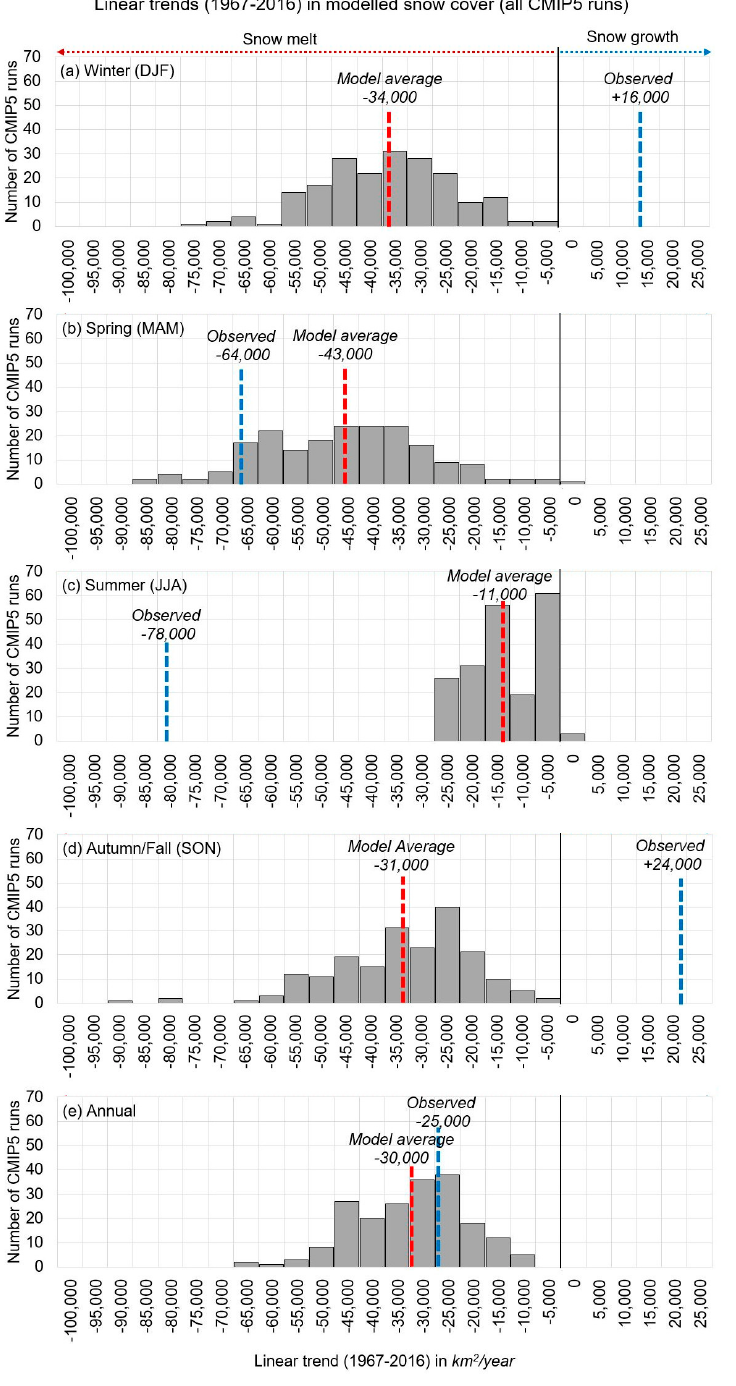
Figure 3. Distribution of linear 1967–2016 Northern Hemisphere snow cover trends for all 196 CMIP5 simulations for ( a ) winter, ( b ) spring, ( c ) summer, ( d ) autumn/fall, and ( e ) annual averages. The observed trends for each season (or yearly average) are indicated with dashed, blue lines in each